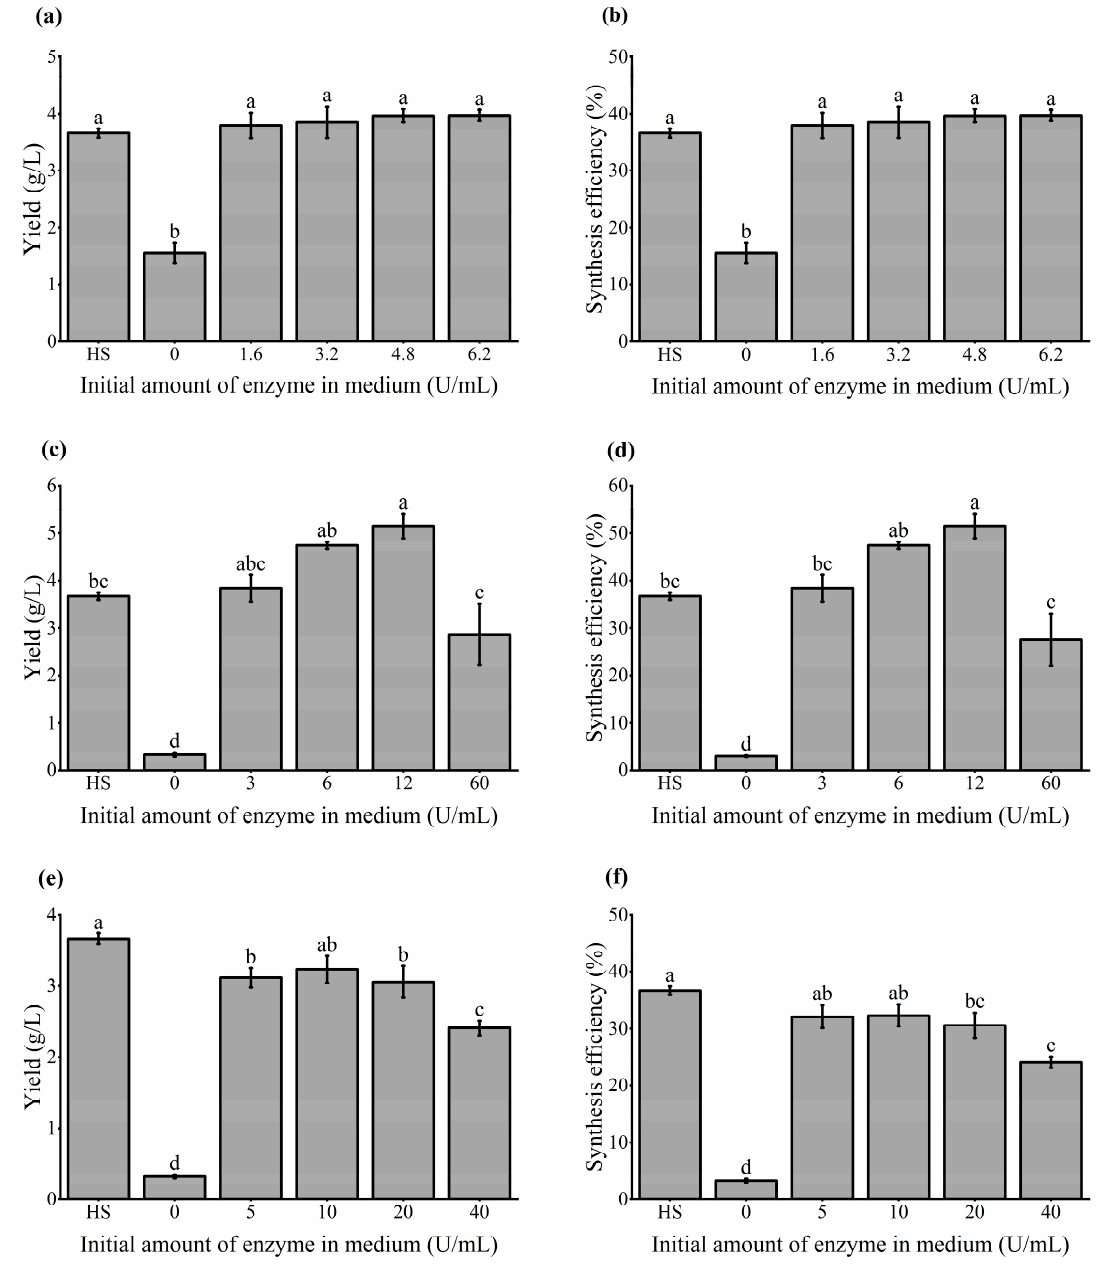
Figure 3. BC synthesis yield and efficiency for samples growing on medium containing sucrose ( a , b ), lactose ( c , d ), and starch ( e , f ), supplemented accordingly with β -D-Fru, β -Gal, and GLA in proper units’ concentration. Bars marked as HS refers to parameters of K. xylinus cultures maintained on standard Hestrin-Schram medium with glucose as the sole carbon source. The means with common superscript are not significantly different from each other ( p < 0.05). Error bars represent standard deviation.